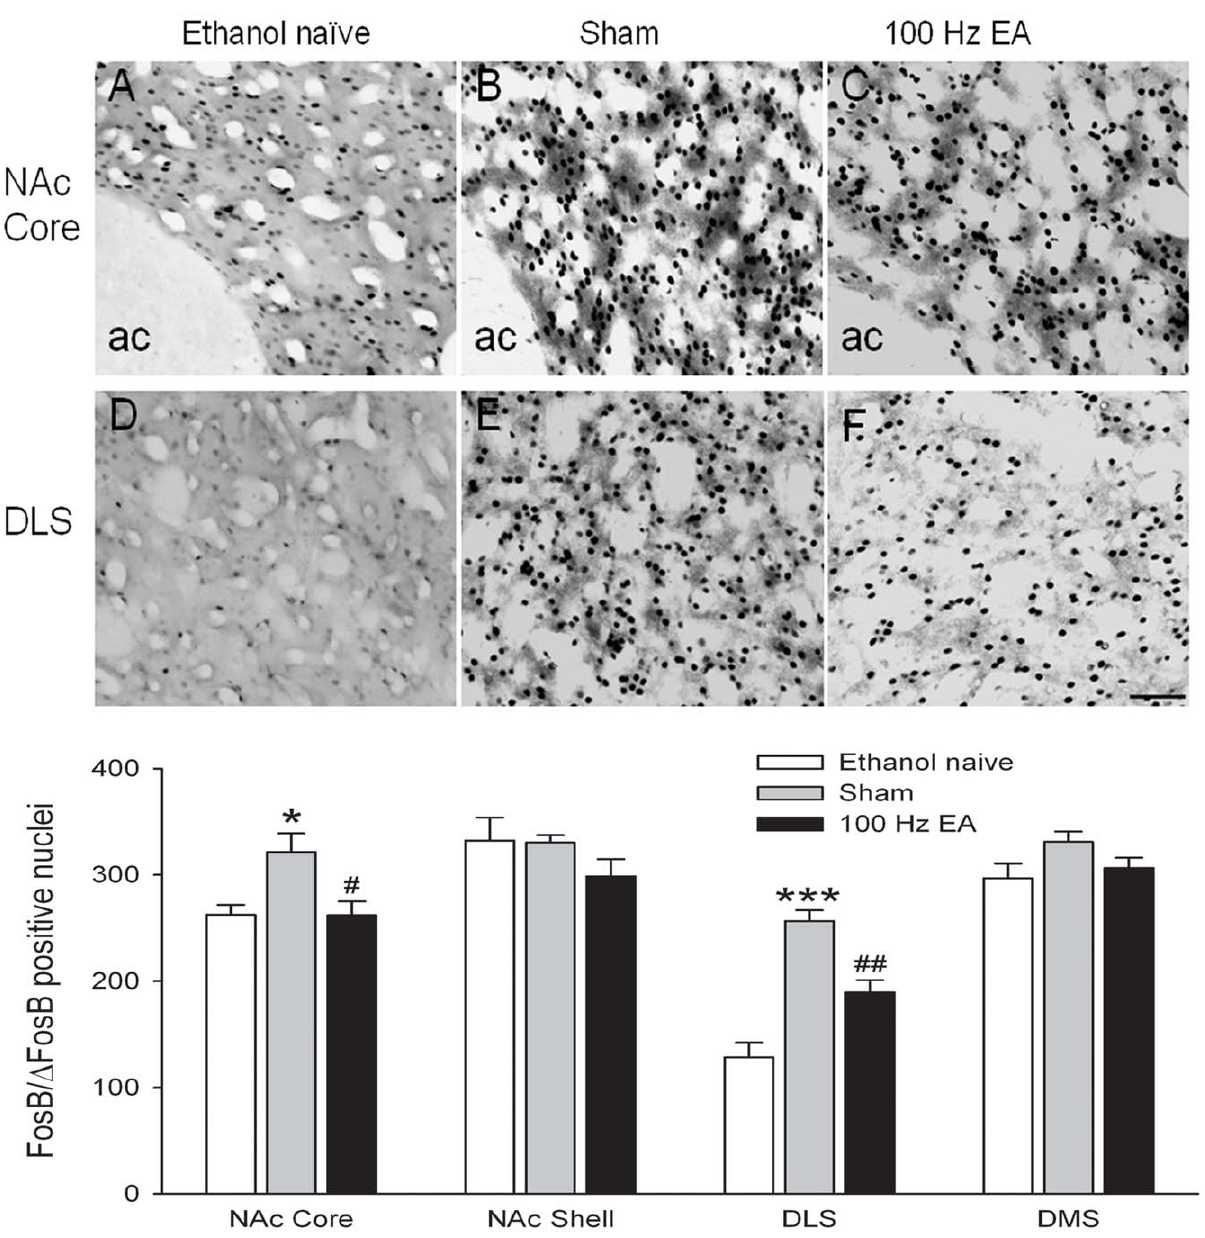
Figure 6. Photomicrographs depicting typical regions of analysis for the NAc core, shell, dorsolateral striatum (DLS) and dorsomedial striatum (DMS). Panels indicate FosB/ D FosB-positive cells in animals that were drinking water (ethanol naı¨ve, A, D ), drinking large amounts of ethanol treated with sham ( B, E ), and drinking large amounts of ethanol treated with multiple sessions of 100 Hz EA ( C, F ). Increased numbers of FosB/ D FosB-positive cells were observed in the NAc core and DLS, but not in the NAc shell and DMS in rats that chronically consumed large amounts of ethanol with sham treatment, as compared with ethanol naive animals. Multiple sessions of 100 Hz EA decreased the accumulation of FosB/ D FosB in the NAc core and DLS induced by excessive ethanol consumption. Data are expressed as mean 6 S.E.M. * p , 0.05, *** p , 0.001 indicates a significant difference from ethanol naı¨ve; # p , 0.05, ## p , 0.01 indicates a significant difference from sham. Scale bar=200 m m. ac: anterior